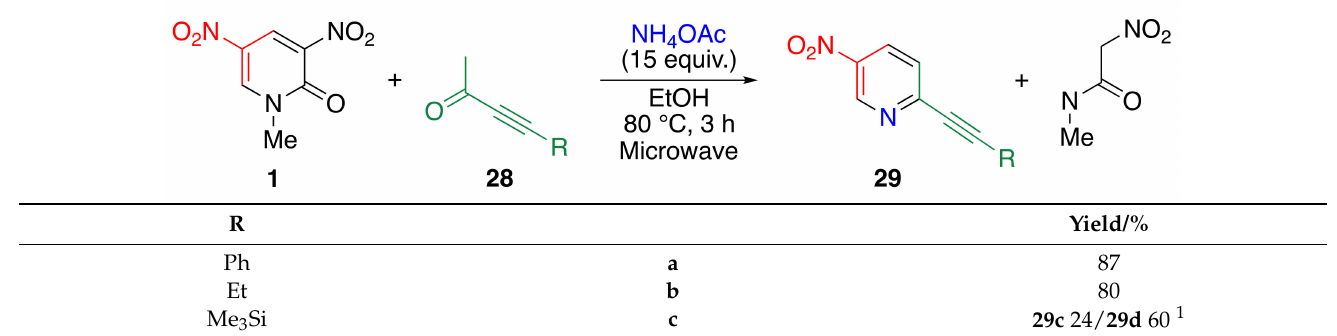
Table 6. TCRT with alkynyl ketones 28 .